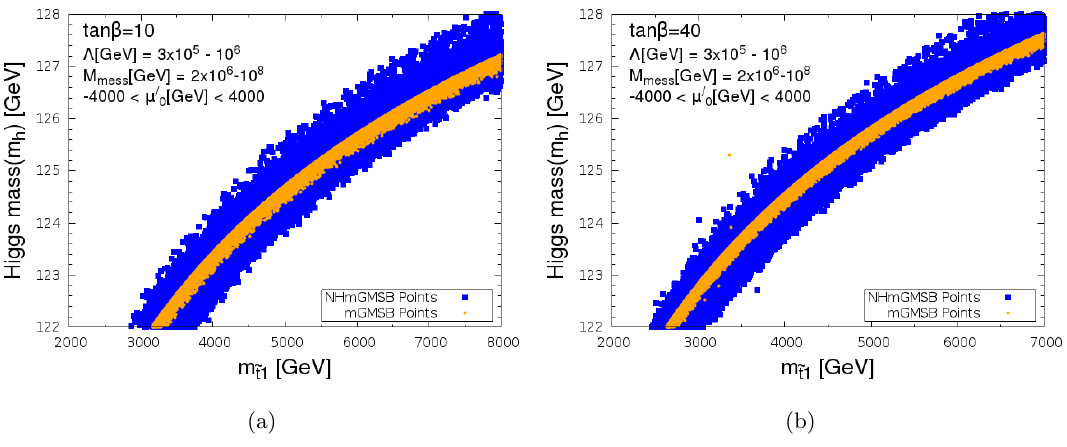
Figure 2 . Scatter plots of m h with stop mass m ~ are scanned according to the ranges mentioned in eq. (3.2). The colors carry the same convention as that of (cid:12)gure